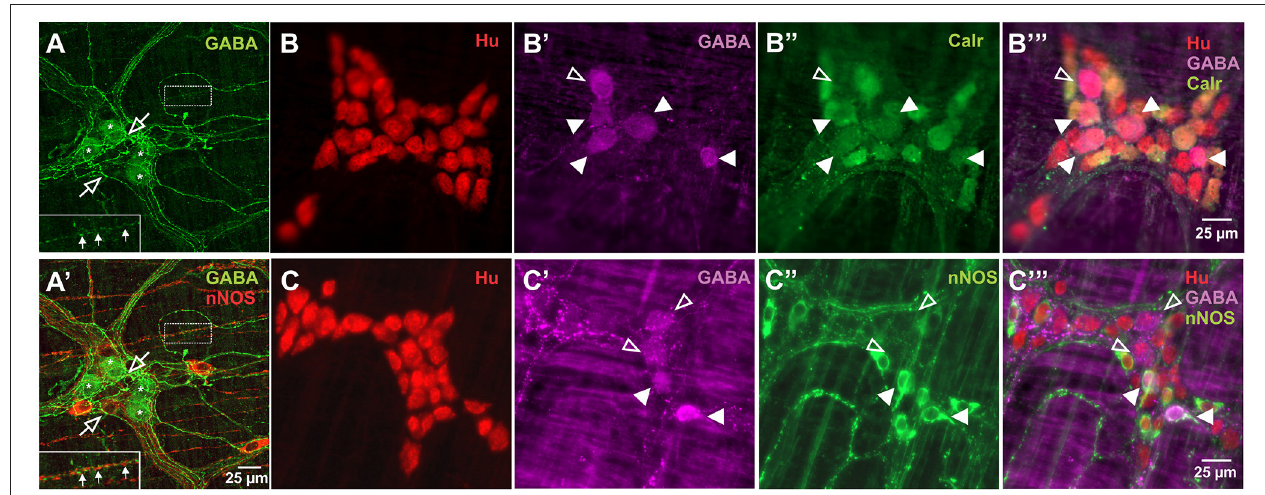
FIGURE 1 | Expression of GABA in relation to Hu, Calretinin and nNOS stains in the myenteric plexus of the mouse ileum. Confocal micrographs of a myenteric ganglion showing GABA immunoreactivity in the somata (asterisks) of some non-nitrergic neurons, terminals and varicosities (open arrows) within the ganglion (A,A’) . GABA and nNOS also stained different varicosities on muscle strips ( A,A’ inset, filled arrows). GABA (B’,B”’,C’,C”’) , Calretinin (B”,B”’) and nNOS (C”,C”’) immunoreactivity were found in some Hu + neurons. Overall, GABA colocalised with some Calretinin + and nNOS + neurons. Example confocal micrographs showing GABA colocalisation with some Calretinin + neurons (B) , and nNOS + neurons (C) (colocalisation—filled arrowheads, no colocalisation—open arrowheads).